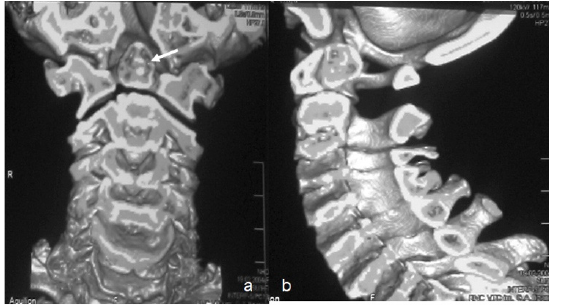
Figure 4. ( a , b ) Three-dimensional reconstruction coronal CT scan of a 14-year-old girl with